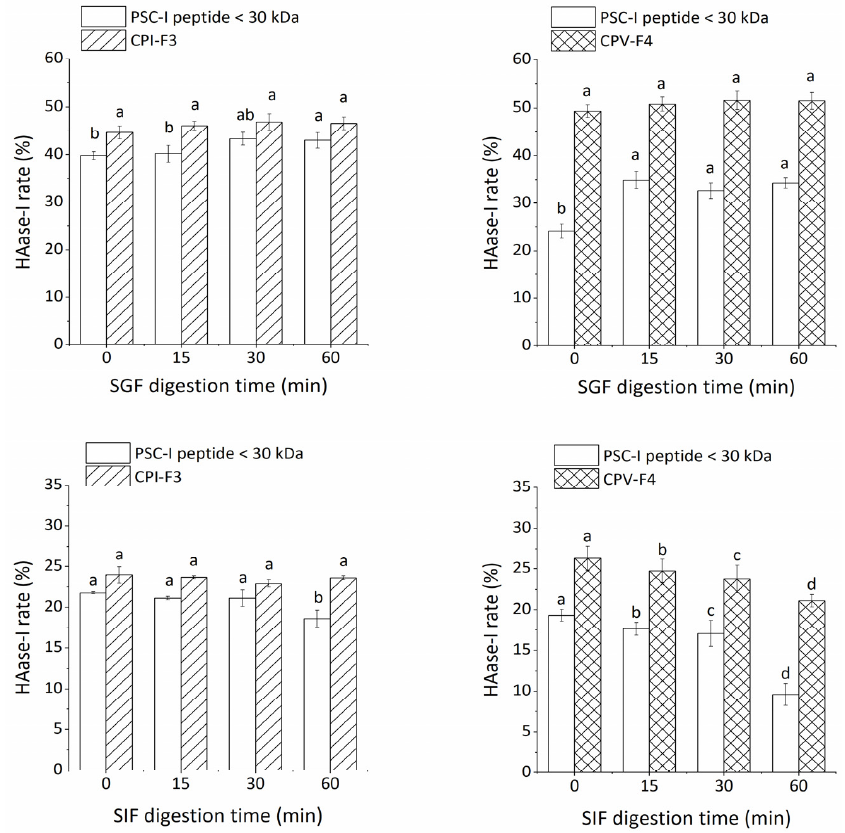
Figure 4. The stability of CPI-F3 and CPV-F4 under SGF and SIF digestion. Different superscripts of the same sample note the significant differences ( p < 0.05). All results are mean ± SD from three determinations.